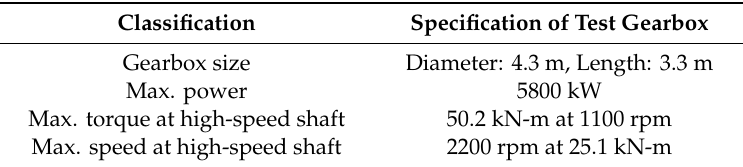
Table 1. Specifications of gearboxes that can be tested.